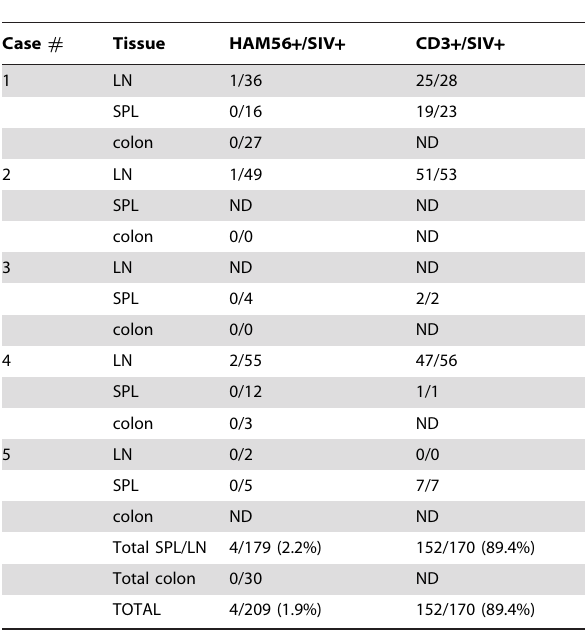
Table 3. Phenotype of SIV + cells in spleen, peripheral lymph node, and colon of SIV D vpx -infected monkeys by double-label in situ hybridization and